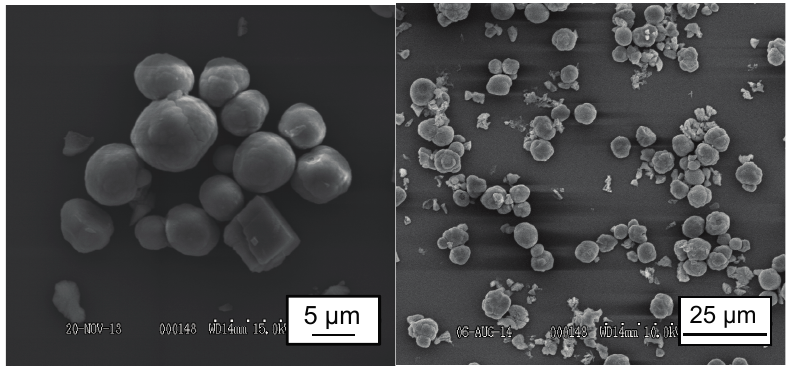
film-coated CaCO microspheres n 3